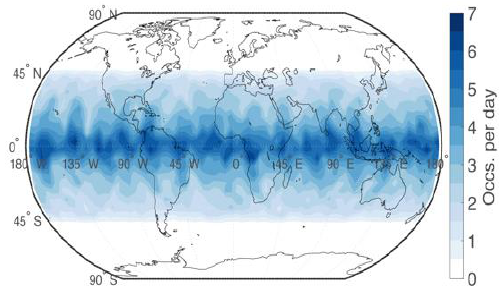
Figure 2. Global distribution of COSMIC-2 RO observation number over a 5 × 5 latitude and longitude grid for a typical day.